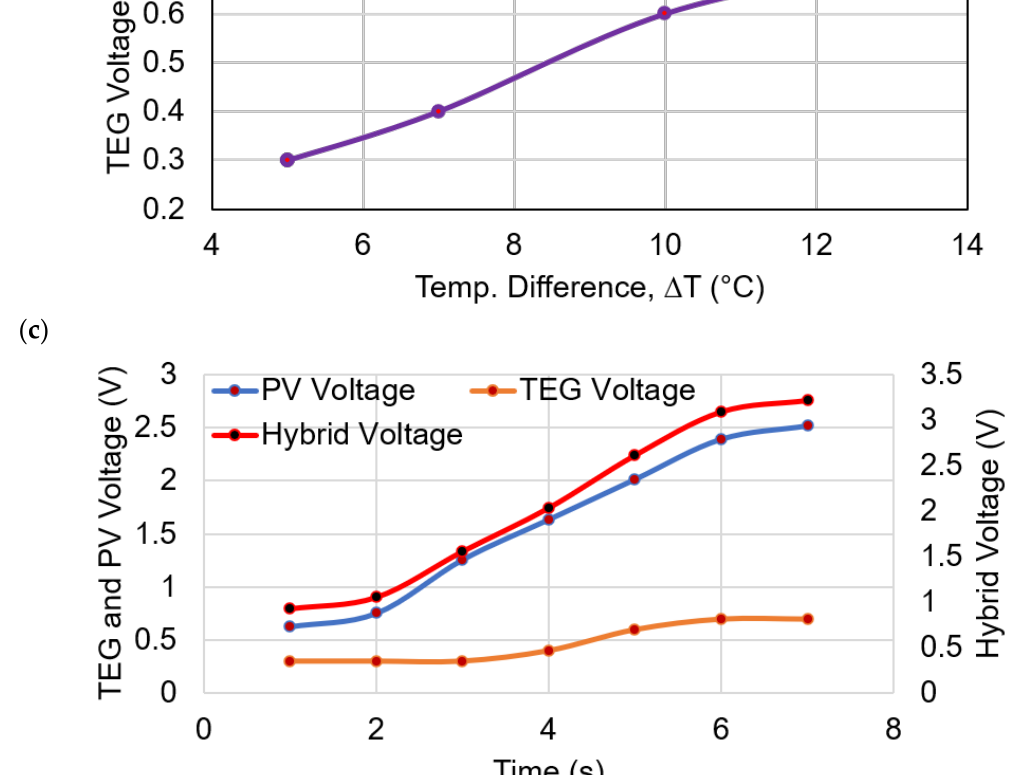
Figure 11. Generated voltages at different light intensity and temperature difference, ( a ) PV voltage vs. lux; ( b ) TEG voltage vs. temperature difference; ( c ) hybrid voltages from PV and TEG.